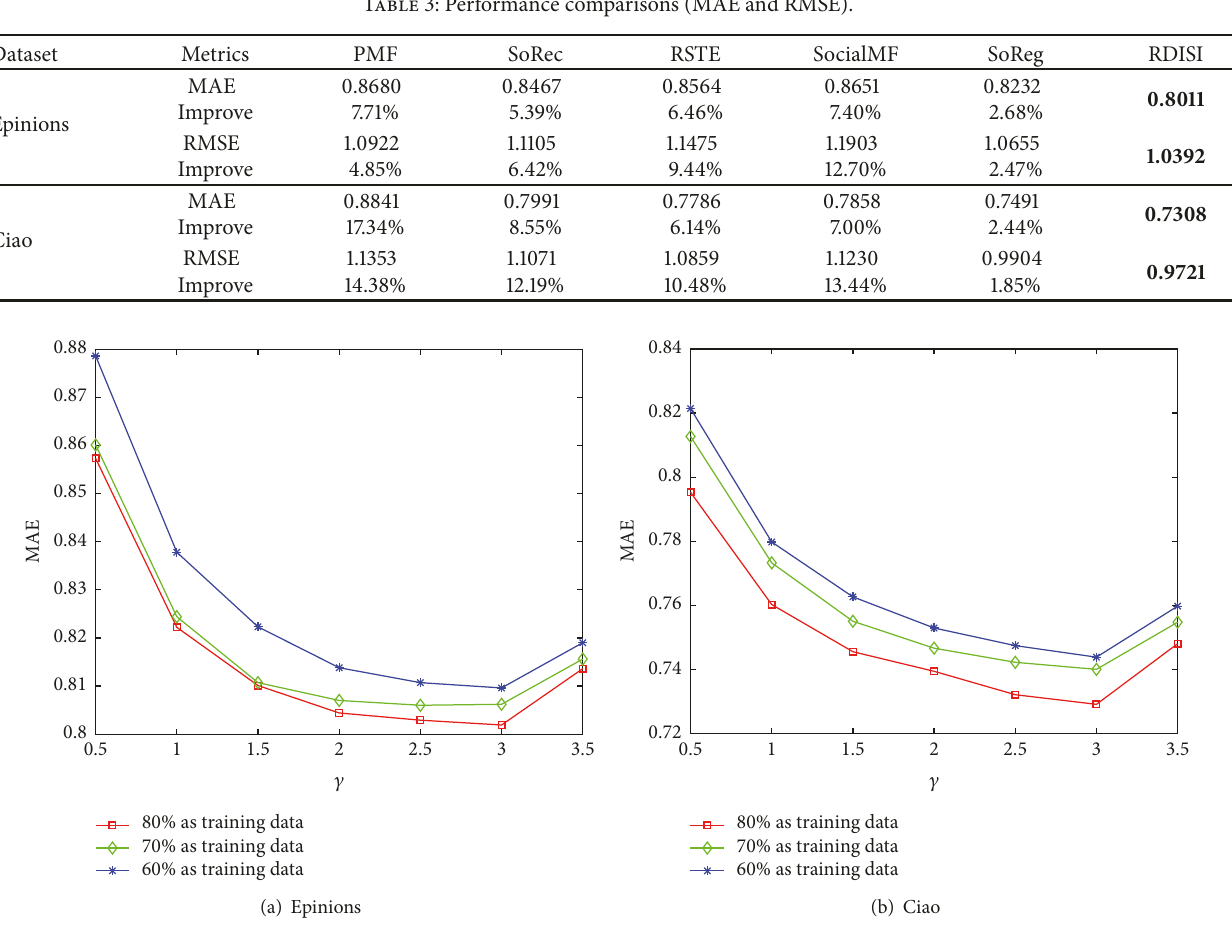
Figure 2: The effect of parameter 𝛾 in different datasets. Table 4: Performance comparisons with other indicators